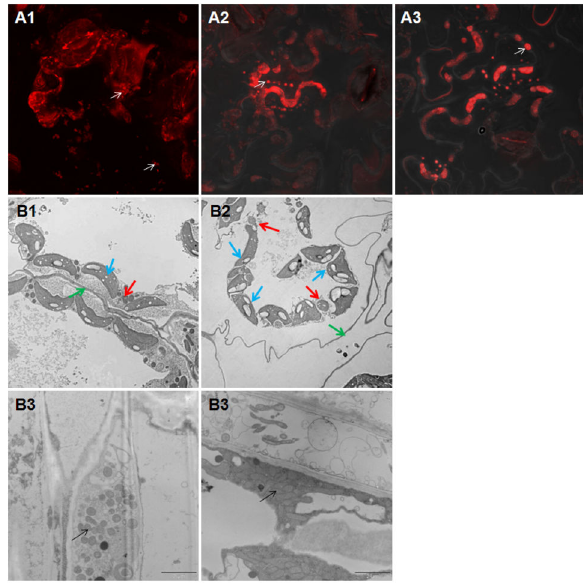
Figure 6. Mitochondria aggregation and morphology in plant cells. A1-A3 : confocal laser scanning micrographs. MitoTracker labeling was detected in tobacco leaves infiltrated with pGDY (A1), pGDY- lasA (A2) and pGDY- lasA (A3). I II Arrows indicate normal and aggregated mitochondria respectively. B1-B4 : transmission electron microscopy micrographs. B1 : normal mitochondria (red arrow), chloroplast (blue arrow) and cell wall (green arrow) from infiltrated pGDY. B2 : enlarged mitochondria (red arrow), abnormal chloroplast (blue arrow) and detached cell wall (green arrow) from infiltrated pGDY- lasA . B3 : normal mitochondria (arrow) from I healthy periwinkle. B4 : aggregated abnormal mitochondria (arrow) from Las-infected periwinkle. doi: